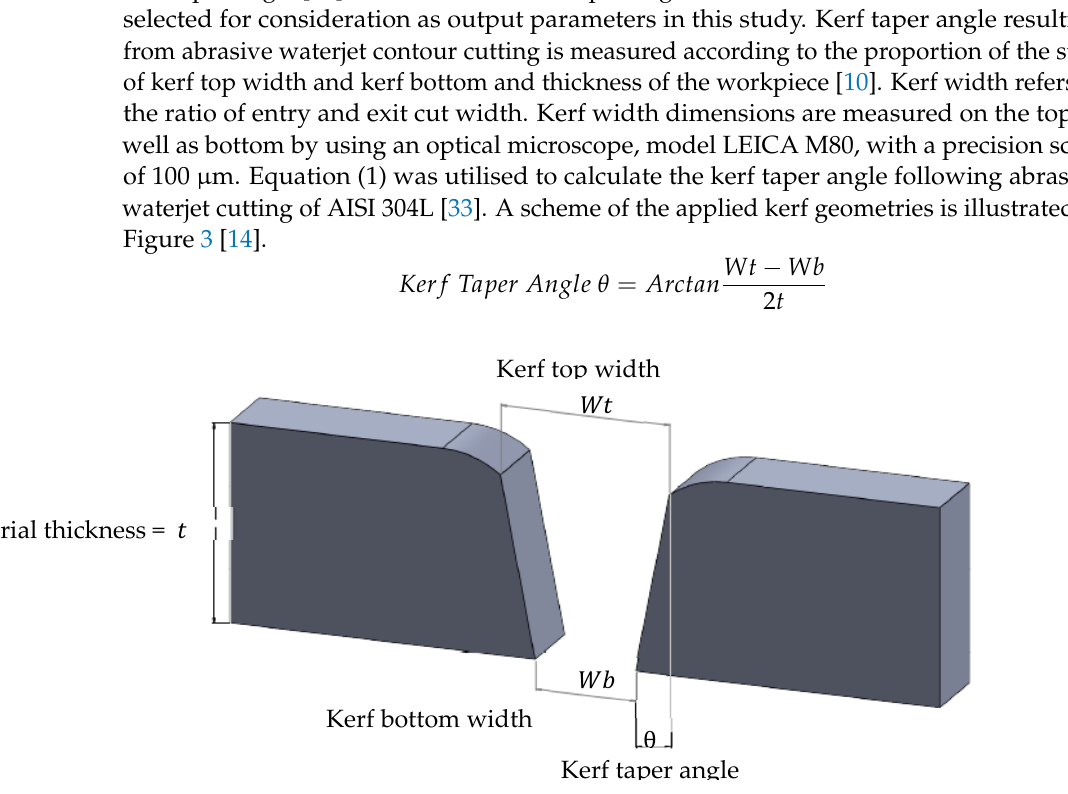
Figure 3. Scheme of AWJM kerf geometries.